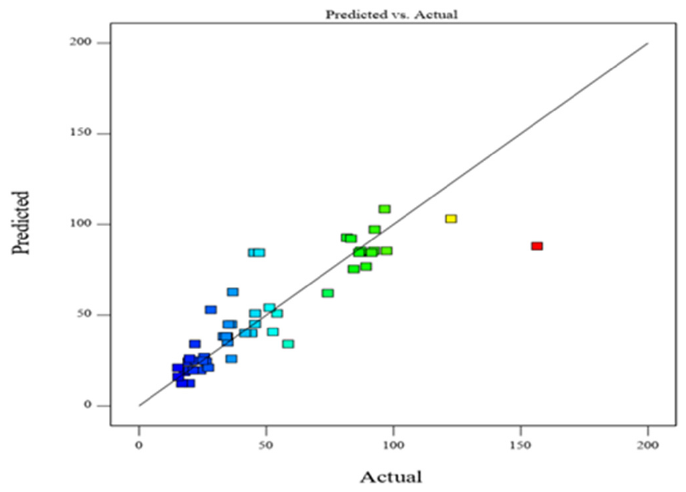
Figure 1. Central Composite Design (CCD) model shows the Graphical representation of Predicted vs. Actual response where different colors are indicated by the value 15.32 156.43 of Lovastatin (mg/L). Table 2. Model Summary Statistics.